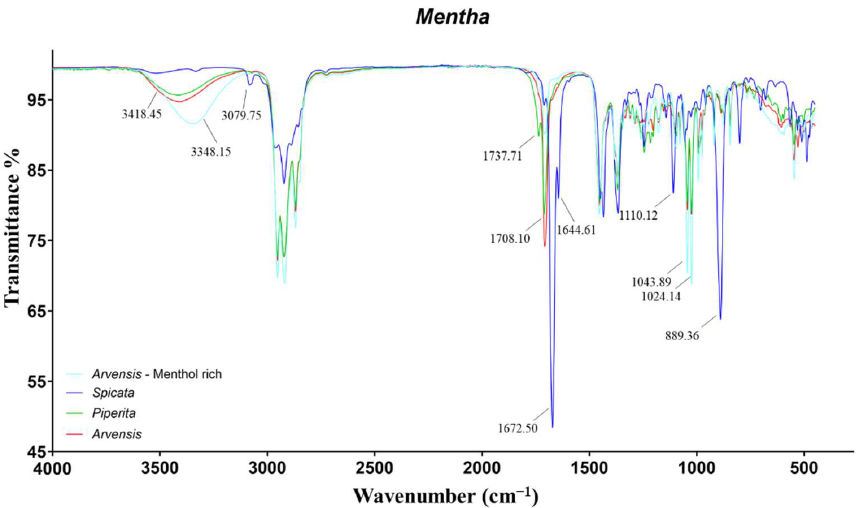
Figure 1. ATR-FTIR spectra of Mentha piperita , Mentha spicata , and two Mentha arvensis with different content of menthol.